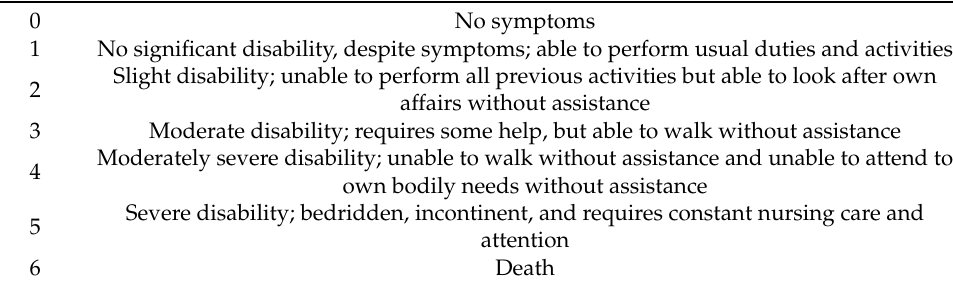
Table 1. Modified Rankin Scale